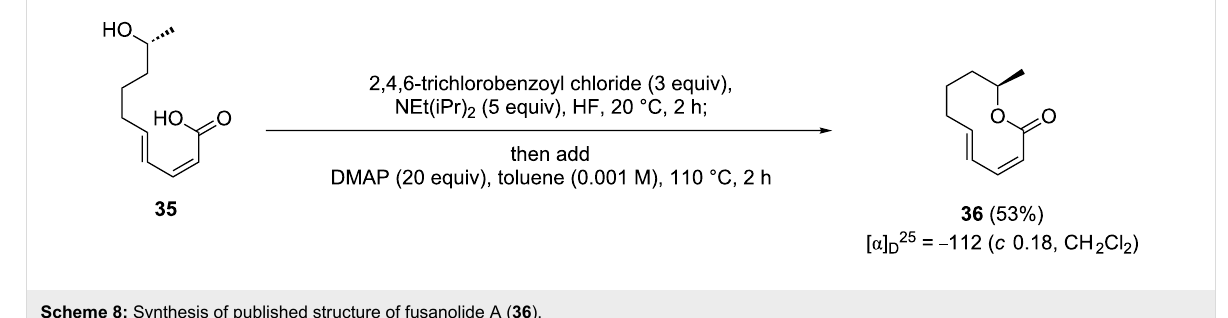
Scheme 8: Synthesis of published structure of fusanolide A ( 36 ).